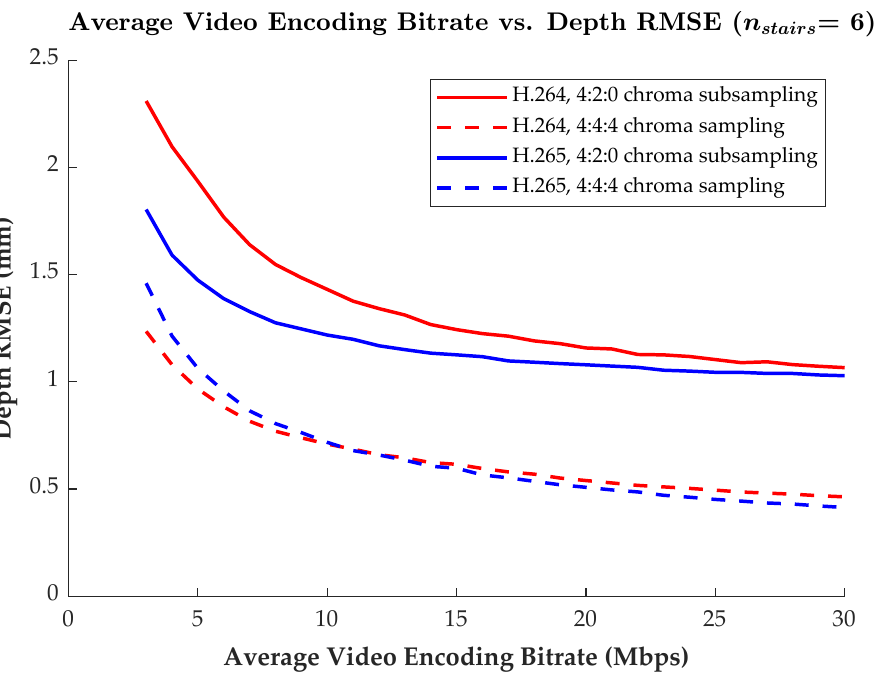
Figure 6. Plot of video encoding bitrate versus the RMSE in the recovered depth values. Results for the H.264 and H.265 codecs with both 4:2:0 chroma subsampling and 4:4:4 chroma sampling are included for comparison. The RMSE is measured as an aggregate over the entire 582-frame reference video encodings. The MWD encoding used n stairs = 6 and other settings were as described in the first paragraph of Section